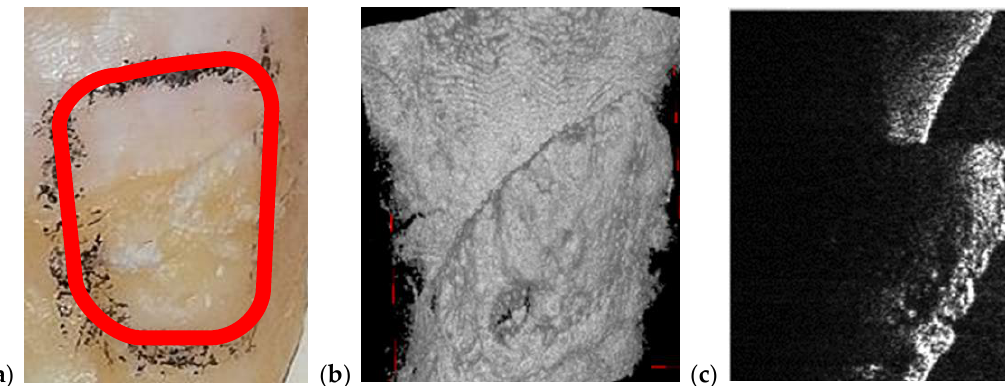
Figure 14. Deep crack in the enamel layer observed on ( a ) part of the photo of an extracted tooth, as well as on ( b ) the 3D OCT reconstruction of the selected area. ( c ) OCT B-scan showing the shape of